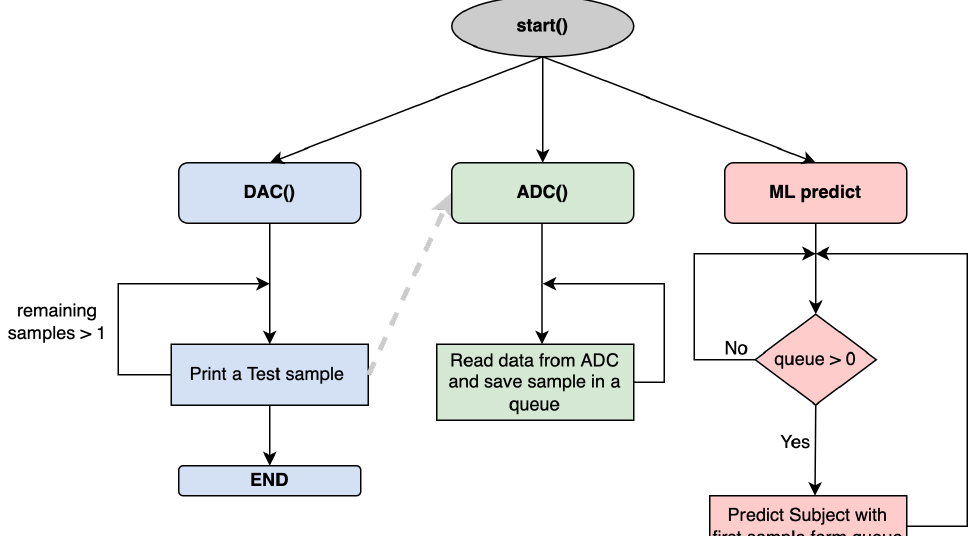
Figure 8. Real-time acquisition